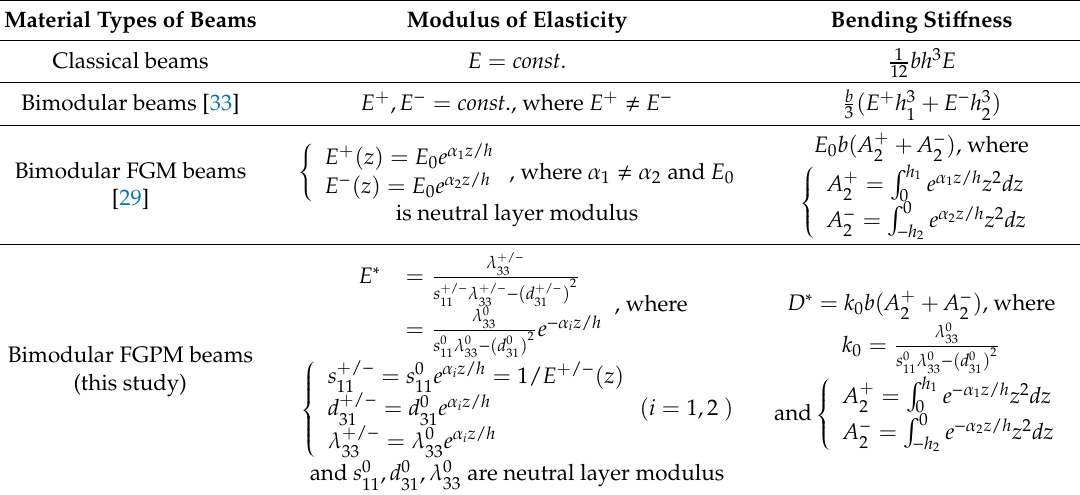
Table 7. Evolution for one-dimensional solution of beams (rectangular